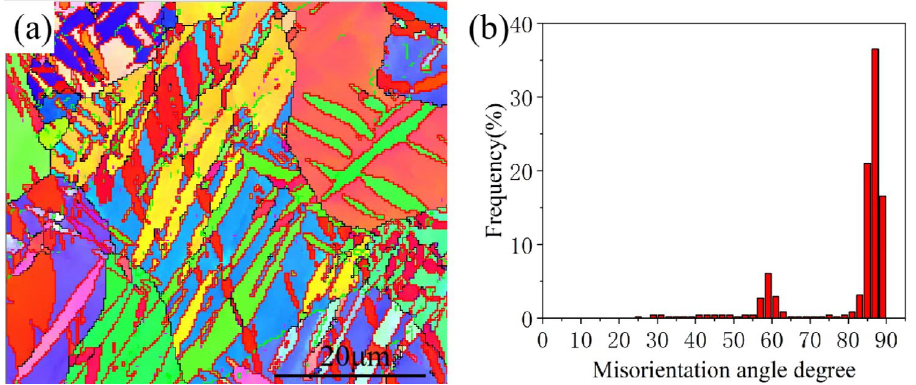
Figure 4. ( a ) is the magnification image of white rectangular zone in Figure 3a; ( b ) is the distribution of misorientation angles corresponding to Figure 4a.